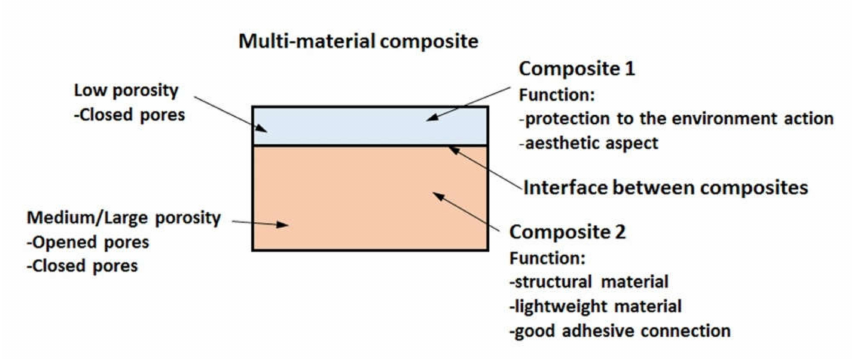
Figure 1. Schematic representation of the multi-material